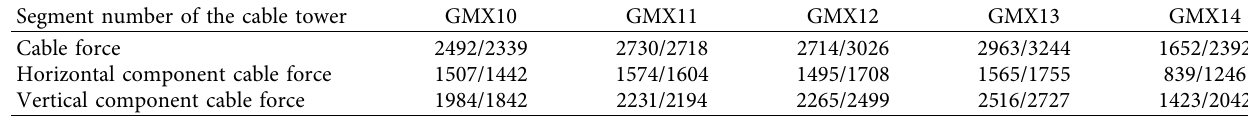
Table 1: Cable forces of cable tower segments under dead load condition (kN).